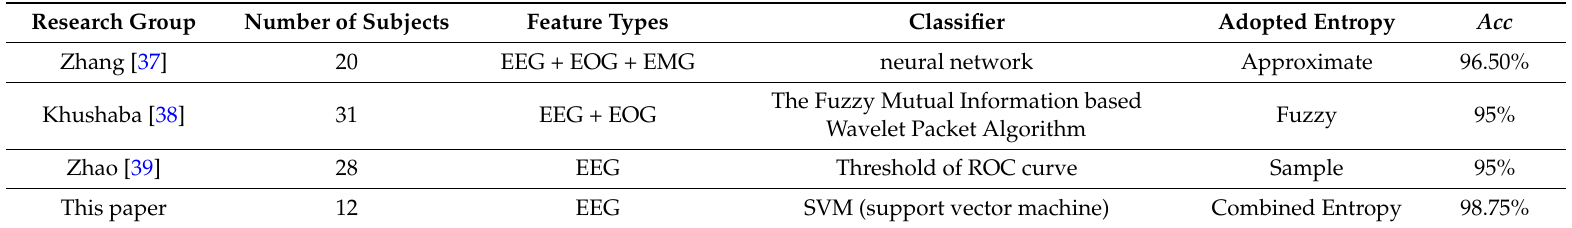
Table 4. Studies regarding driver fatigue detection using different types of entropy. EOG: